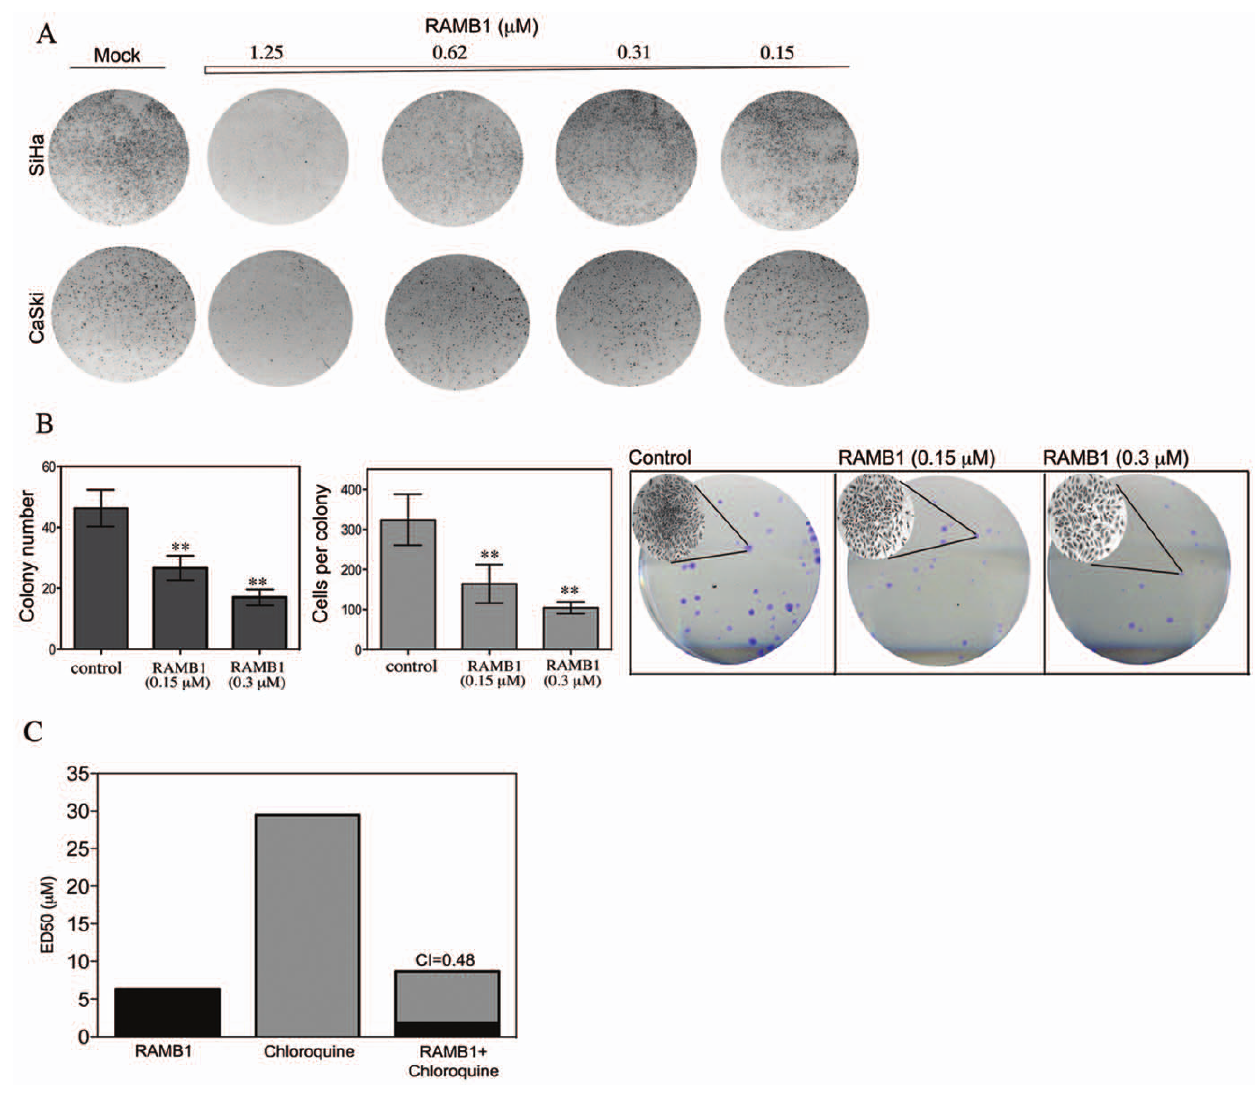
Figure 8. RAMB1 treatment prevents anchorage-dependent colony formation and synergizes with Chloroquine to kill cervical cancer cells. A. Equal numbers of SiHa and Caski cells (10 3 ) were seeded into 6-wells plastic dishes and treated with or without RAMB1 at the indicated concentrations over a period of 10 days. Colonies were visualized by crystal violet staining. B. Left panel : Quantification of colony number in mock versus RAMB1 treated HeLa cells. Middle panel : Quantification of colony size in mock versus RAMB1 treated cervical cancer cells. Right panel : Representative experiment of HeLa cells (10 2 ) which were seeded into 6-wells plastic dishes and treated with or without RAMB1 at the indicated concentration over a period of 10 days. Colonies were visualized by crystal violet staining and manually counted using an inverted microscope. Inserts: Representative example of colony size in mock versus RAMB1-treated cells. Middle panel: Quantification of colony number. Right panel : Quantification of colony size, representative of three independent experiments. **, P , 0.02. C. CaSki cells were treated with checkerboard dilution series of RAMB1 and Chloroquine over a period of 24 hours. Cell viability was measured by XTT assay and calculated as percent of control untreated cultures. Synergy is expressed as combination index (CI).